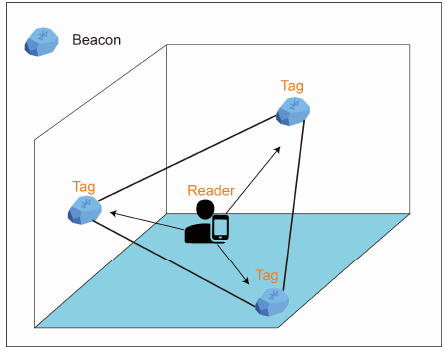
3 Figure 2. Triangulation. Int. J. Environ. Res. Public Health 2021 , 18 , x FOR PEER REVIEW